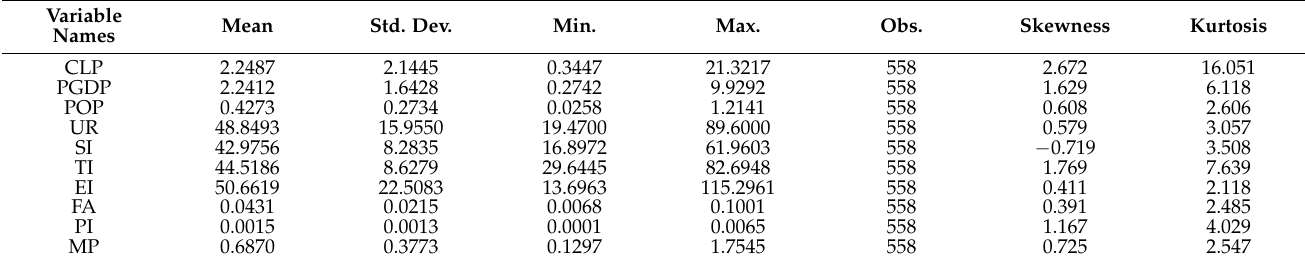
Table 3. Descriptive statistics of the